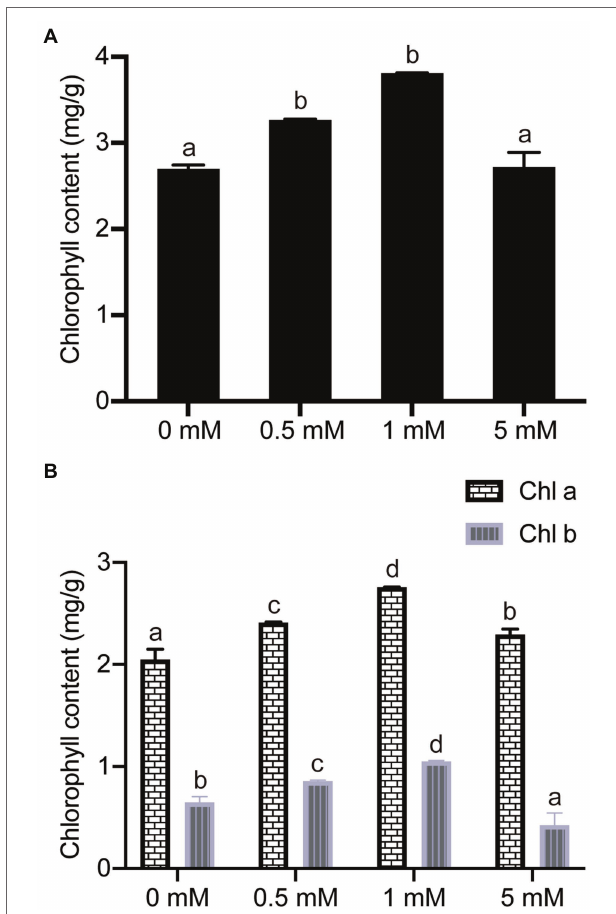
FIGURE 5 | The effects of different P treatments on the chlorophyll concentrations in pear seedlings. (A) Total chlorophyll concentrations; and (B) Chlorophyll a and chlorophyll b concentrations. Data are presented as mean ± standard deviation of three replicates, and each replicate is based on measurements made from three plants. Samples in a bar chart with a common superscript letter are not significantly different ( p > 0.05), according to the Duncan’s multiple range